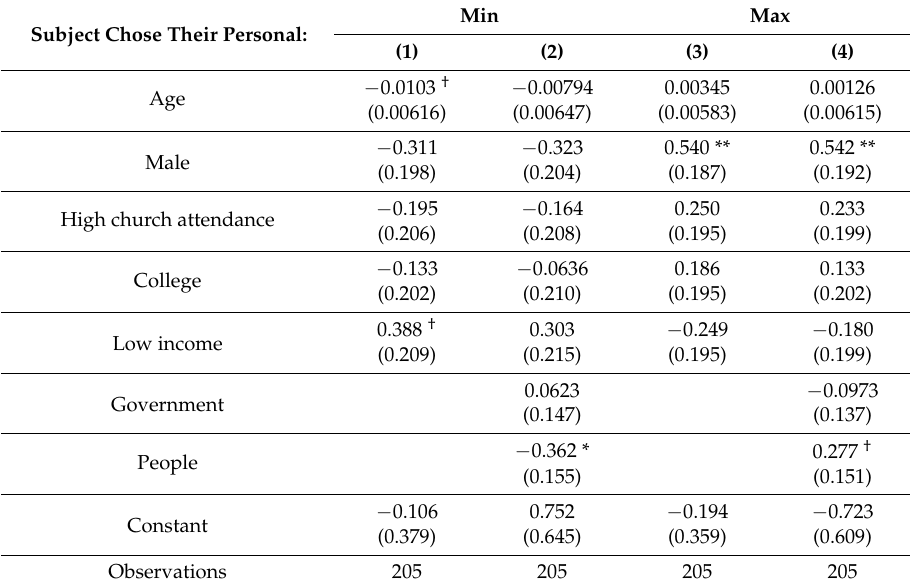
Table A5. Probit results for choosing the min and max in the selected dictator game.